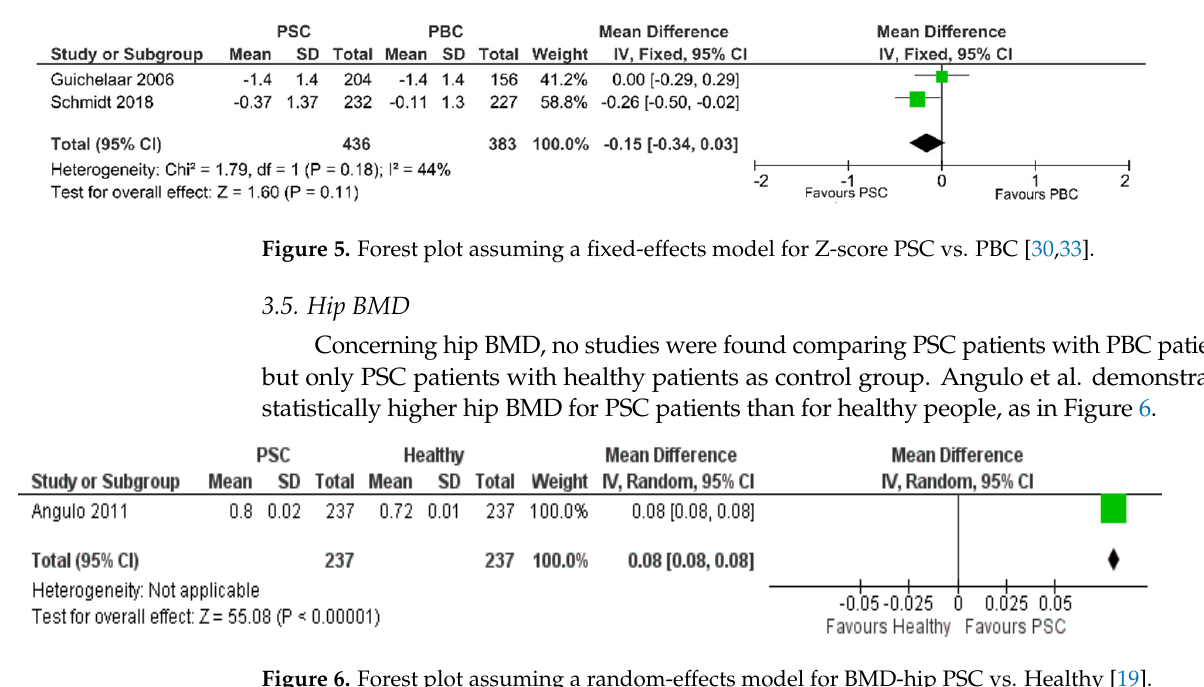
Figure 6. Forest plot assuming a random-effects model for BMD-hip PSC vs. Healthy [19].